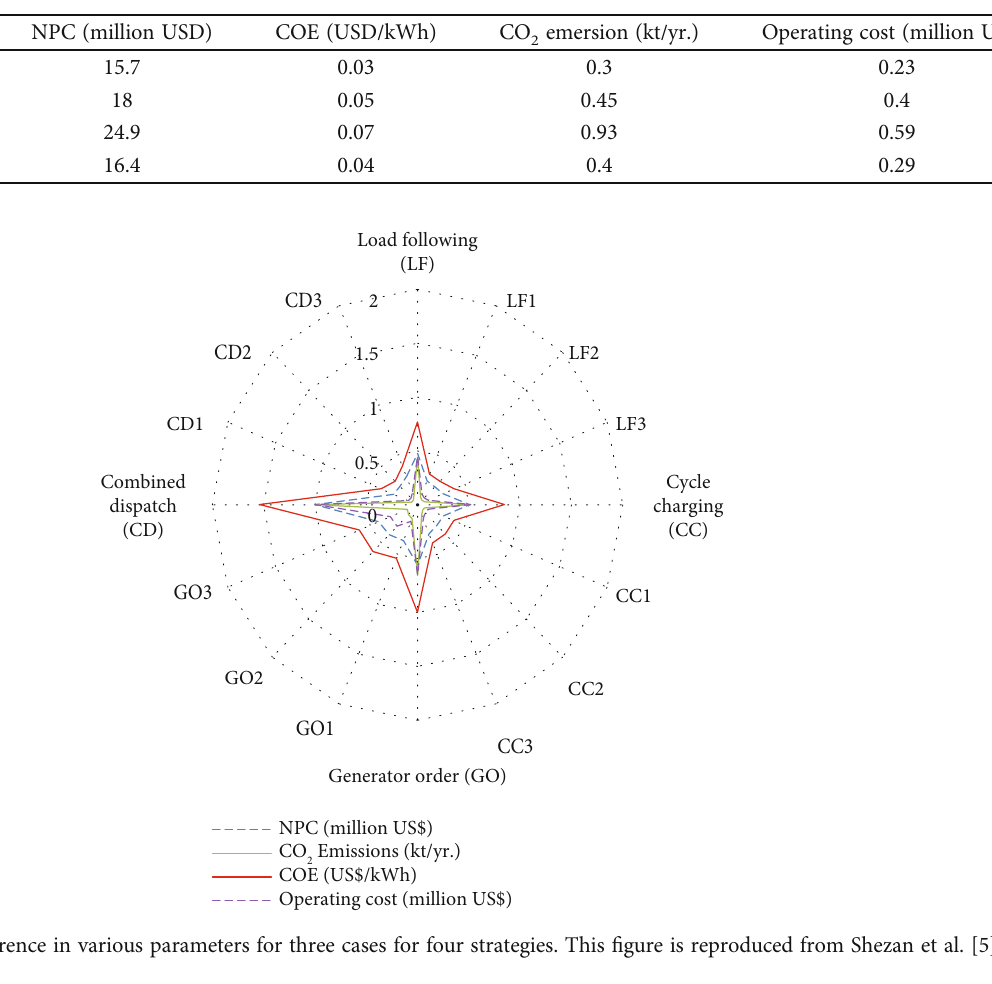
Table 1: Comparison among di ff erent parameters for three cases for four dispatch control.